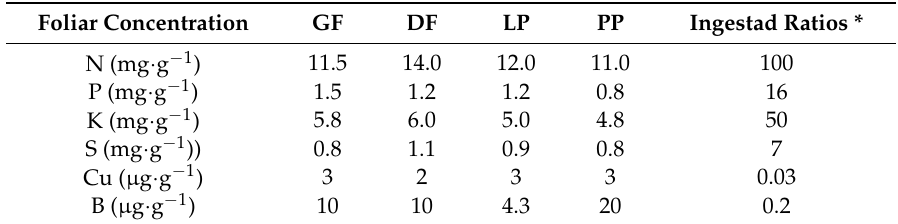
Table 2. Critical nutrient concentrations for inland conifer species: grand fir (GF), Douglas-fir (DF), lodgepole pine (LP), and ponderosa pine (PP) [14]. Foliar Concentration GF DF LP PP Ingestad Ratios *